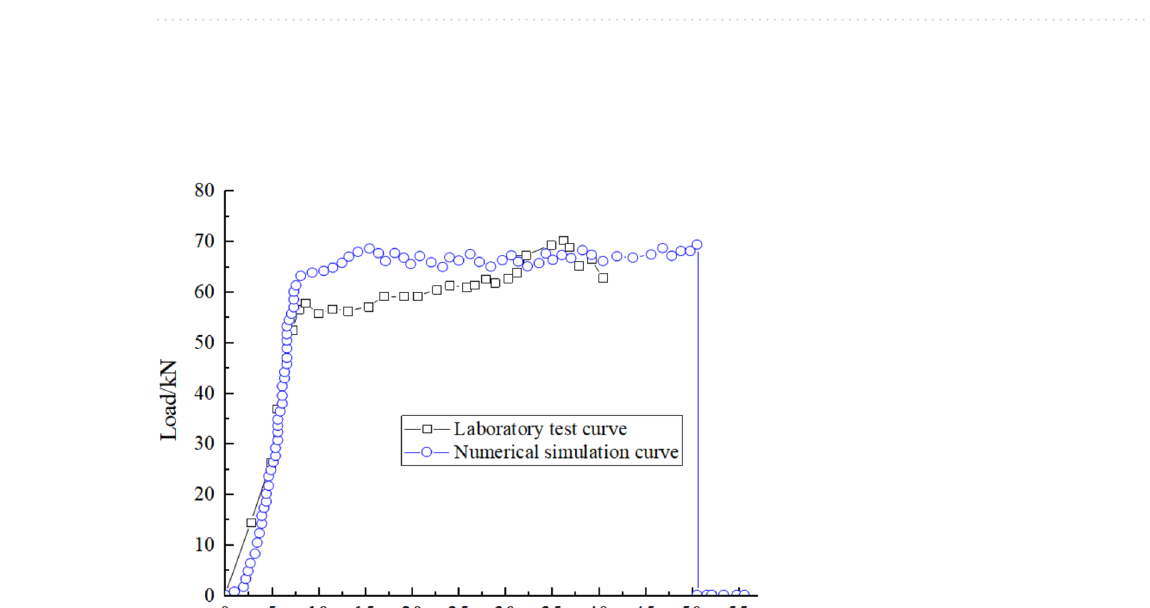
Figure 6. Comparison of pull-out test loading process.